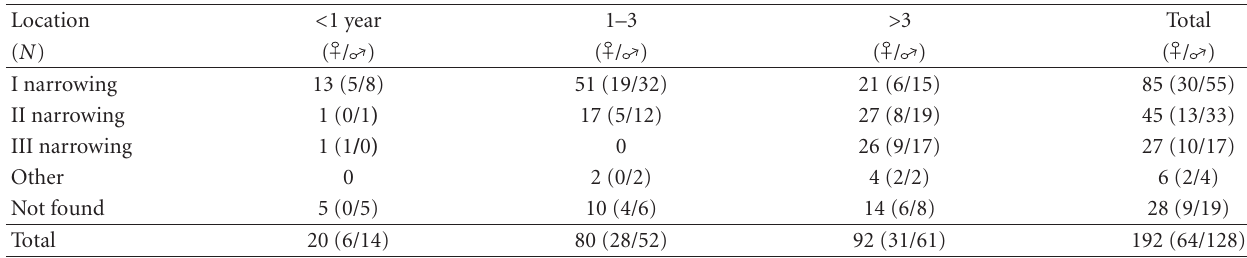
Table 1: Location of an FB concerning age and gender.